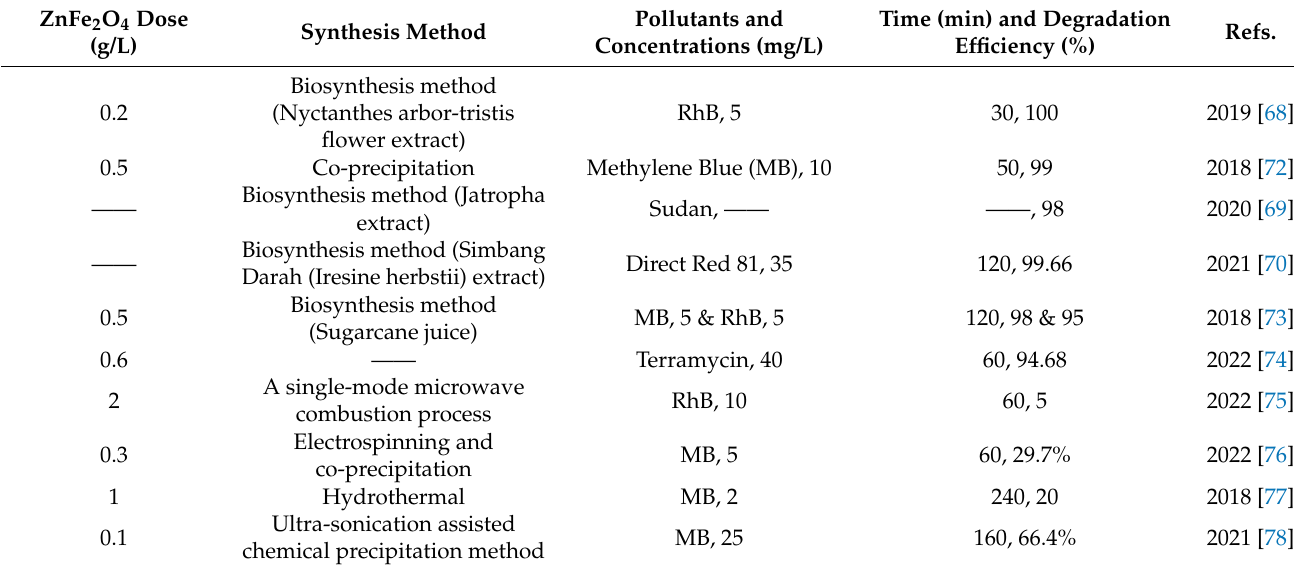
Table 1. A comparison of the photodegradation rate of organic pollutants by ZnFe 2 O 4 with different preparation